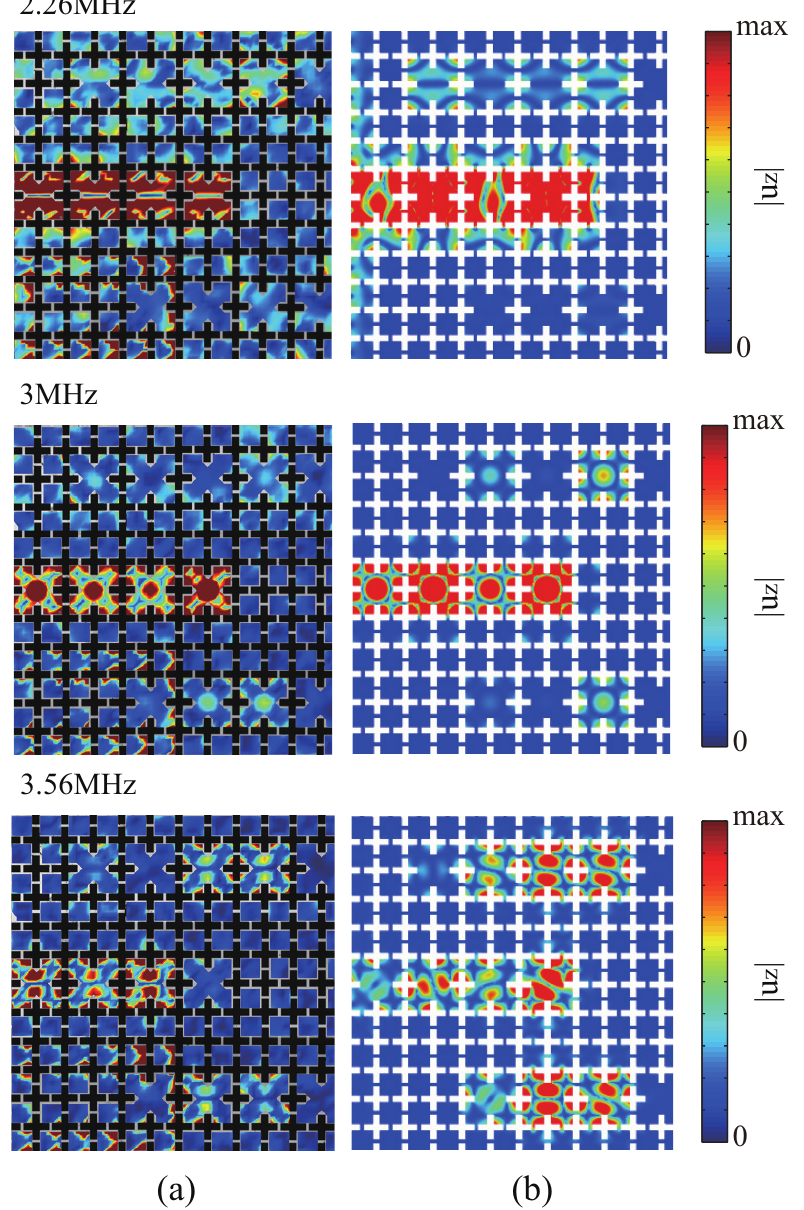
Figure 4. Experimental ( a ) and numerical ( b ) out-of-plane displacement maps at frequencies 2.26 MHz, 3 MHz, and 3.56